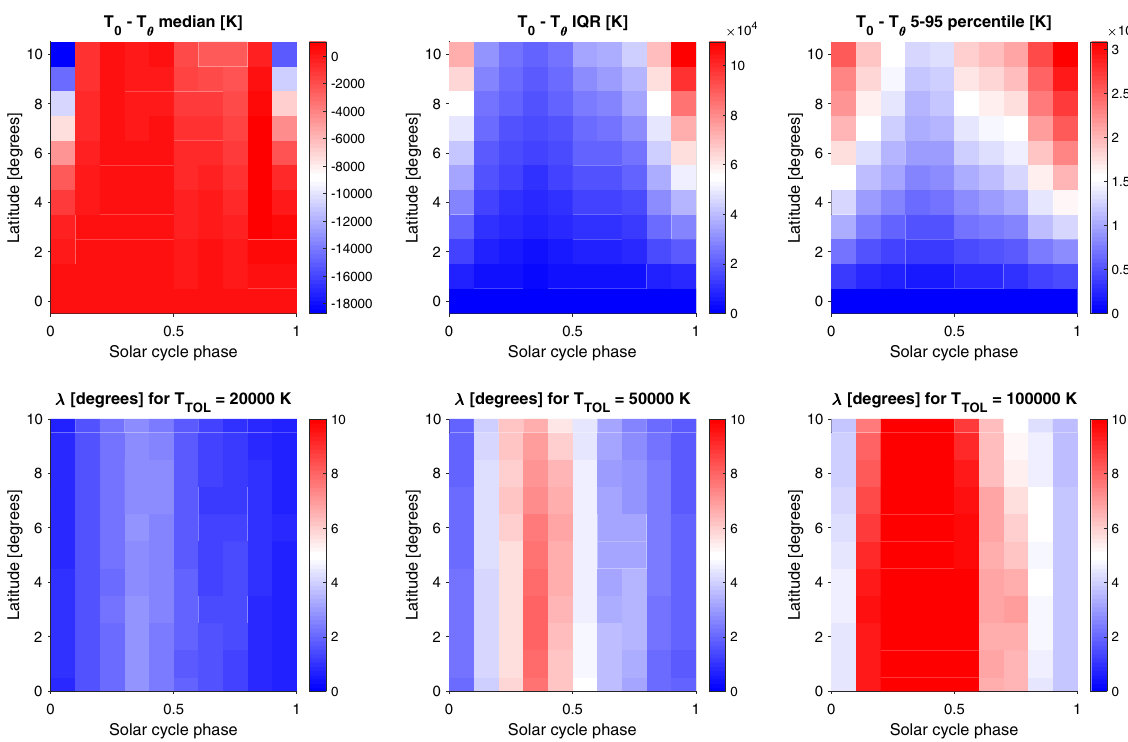
Fig. 13. Summary plots for the solar wind temperature, T , in the same format as Figure